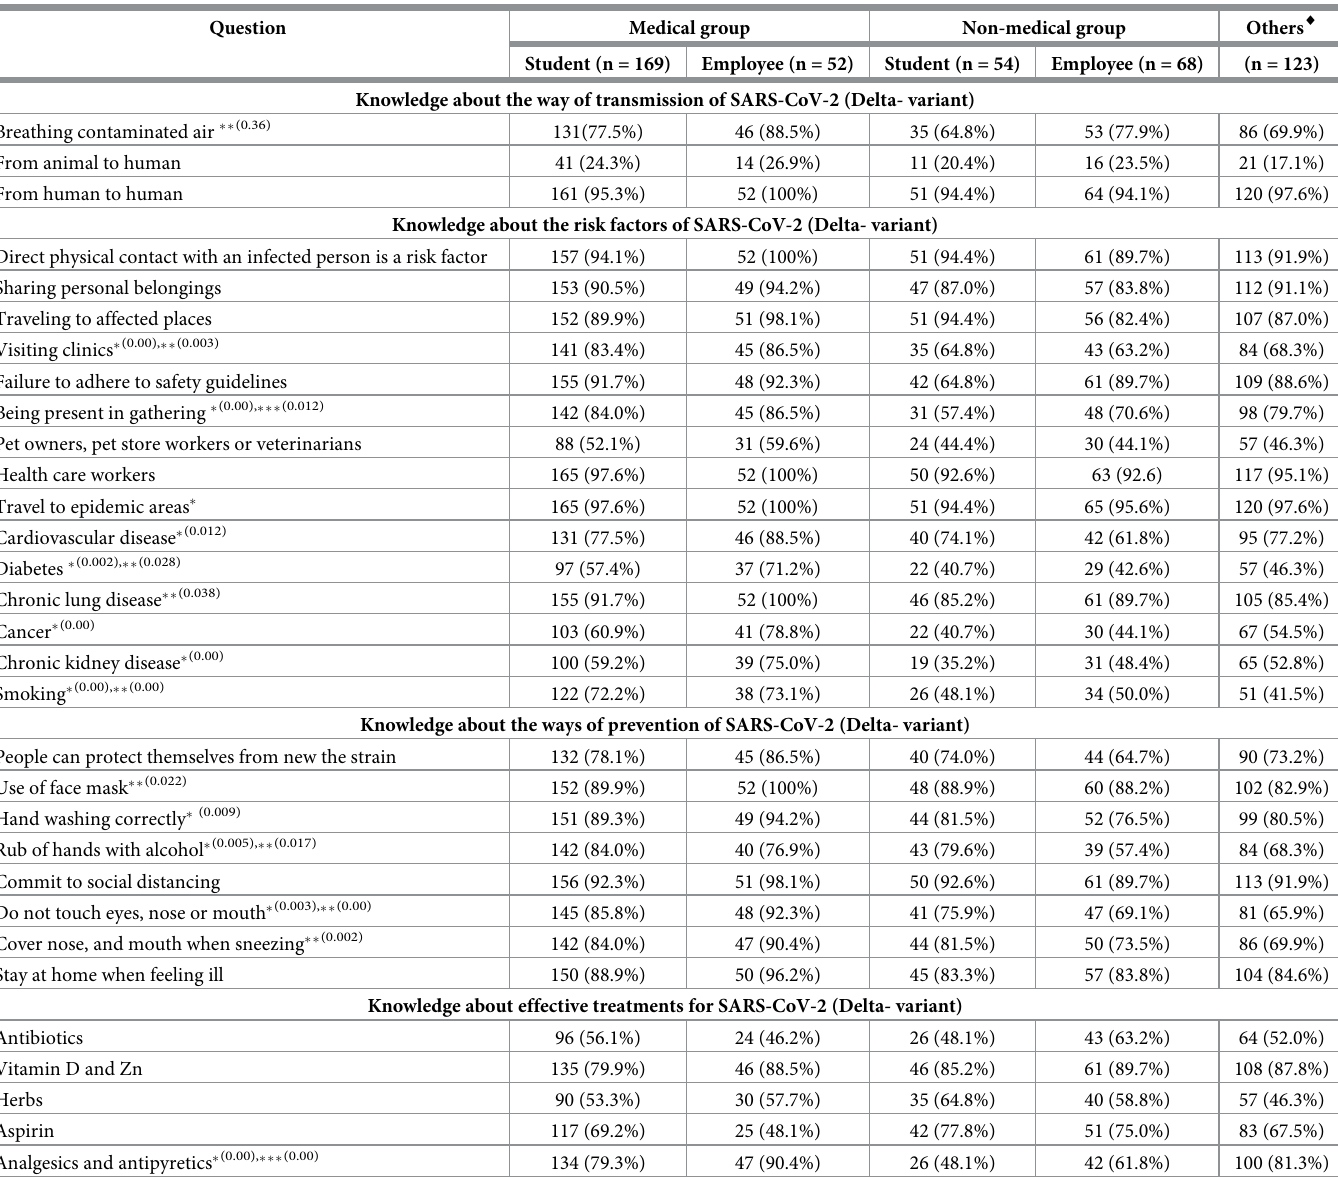
Table 4. Participants’ knowledge regarding SARS-CoV-2 (Delta- variant) transmission, risk factors, prevention and treatment.